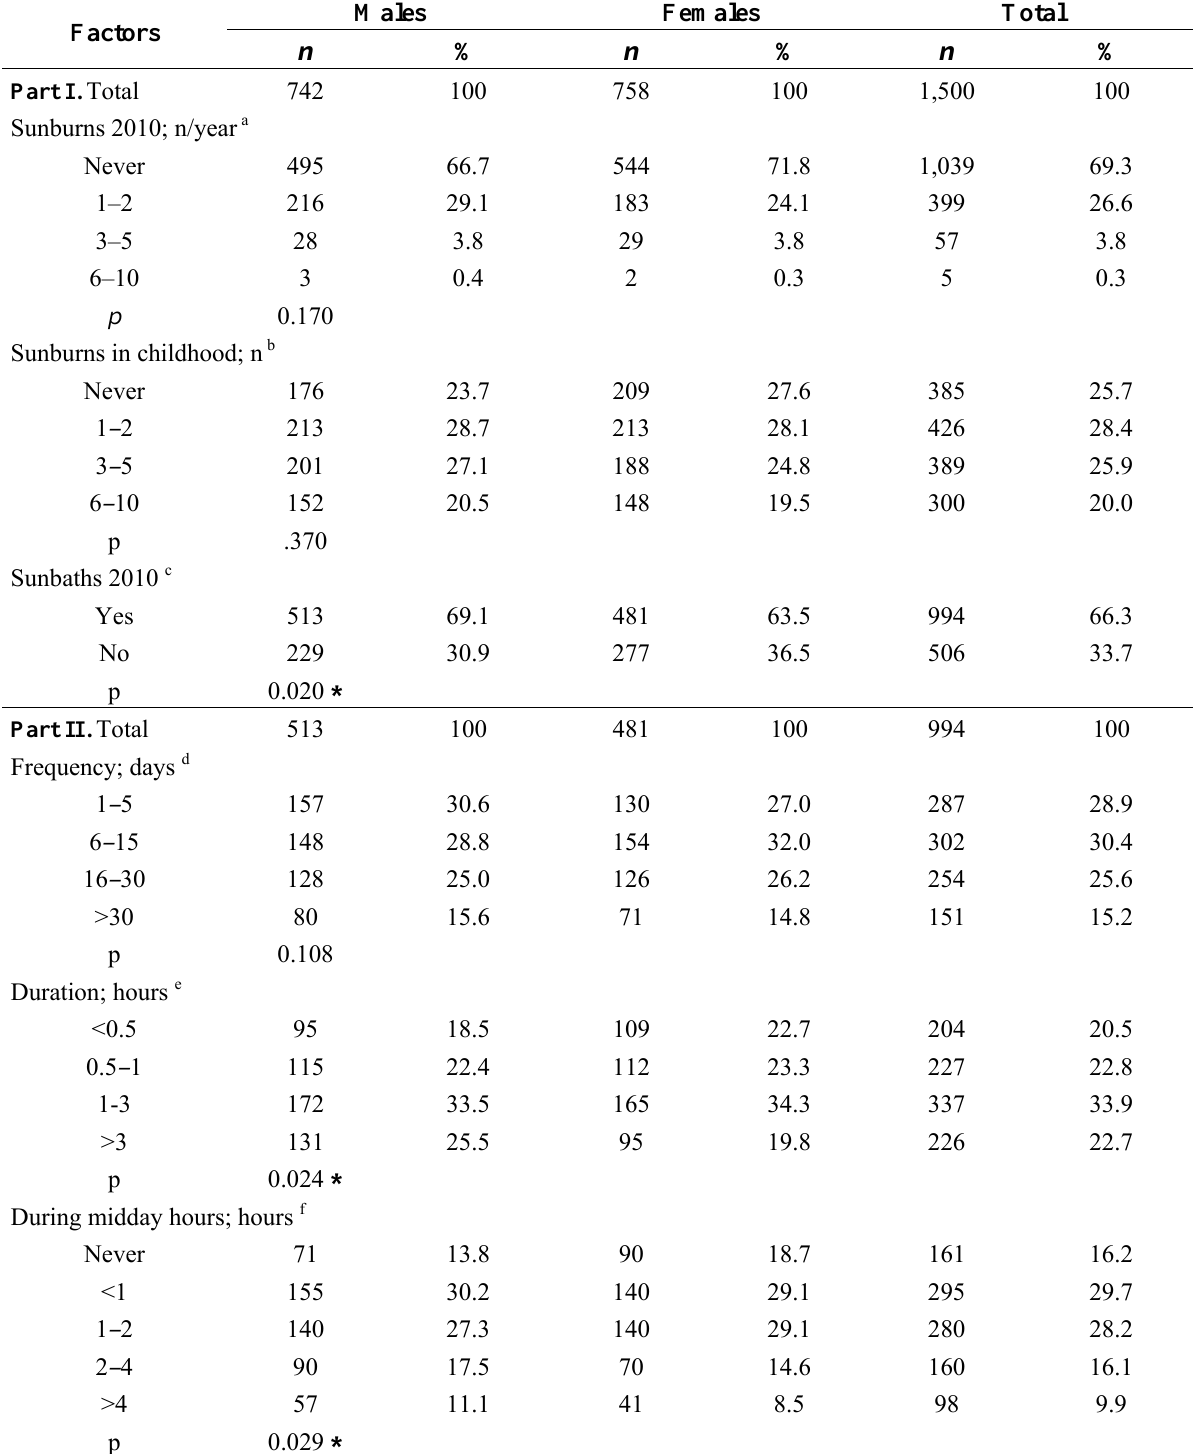
Table 1. Gender differences of (part I) reported sunburns and sunbaths as well as (part II) frequency and duration of outdoor tanning